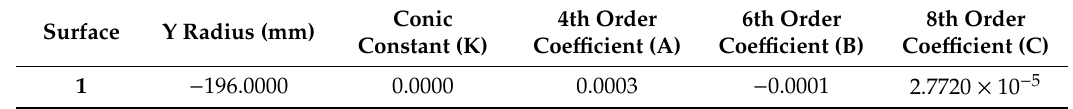
Table 5. Detailed parameters of aspherical surfaces for the real